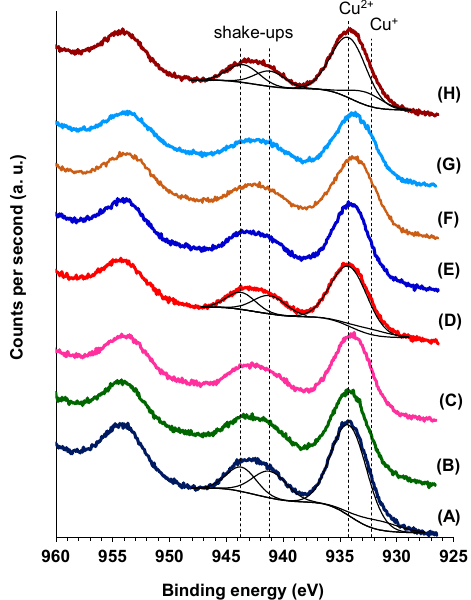
Figure 5. Cu 2p core level XPS spectra of the mixed oxides: CuCeMgAlO (A), Mn(3)CuCeMgAlO (B), Fe(3)CuCeMgAlO (C), Co(3)CuCeMgAlO (D), Ni(3)CuCeMgAlO (E), Co(1)CuCeMgAlO (F), Co(6)CuCeMgAlO (G), Co(9)CuCeMgAlO (H).